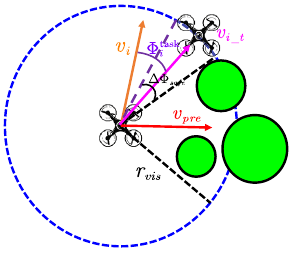
Fig. 5 Schematic diagram of the task information term with adaptive goal-oriented strategy. The orange arrow v i indicates the velocity direc- tion of the drone. The red arrow v pre indicates the preferred direction to the desired region. The pink arrow v i _t indicates the adaptive task information direction. (cid:8) task is the angle of i